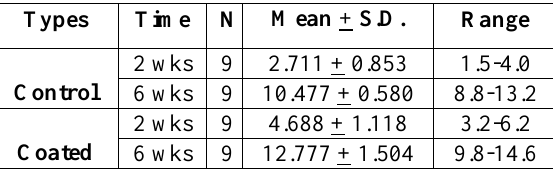
Table 1: Comparison of mean torque value of CaCO 3 coated and uncoated implants between